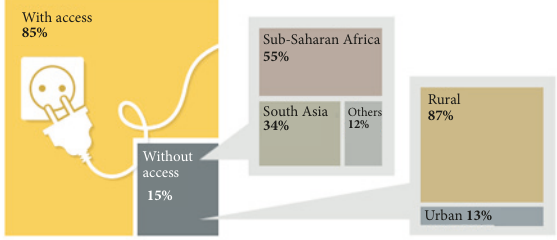
Figure 5: World electricity access and lack of access 2012. Source: REN 21 Global Status Report, 2015.